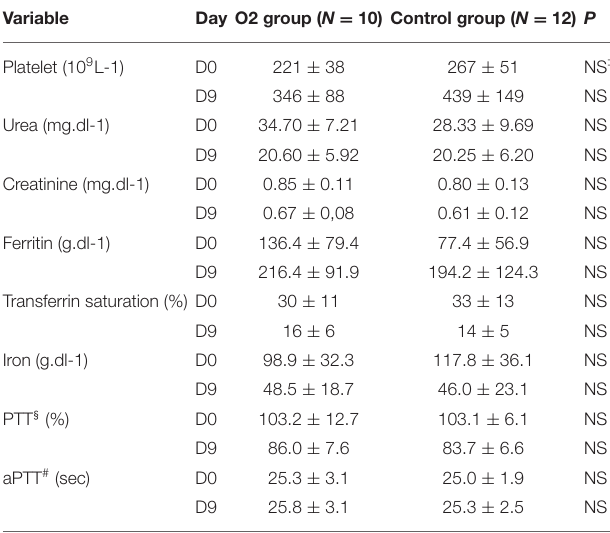
TABLE 1A | Patient characteristics for the O 2 and control groups. Variable